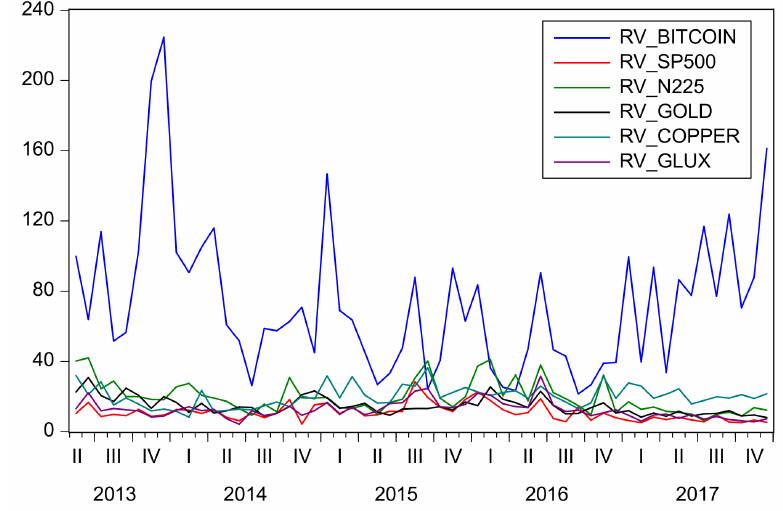
Figure 2. Annualized monthly realized volatilities.